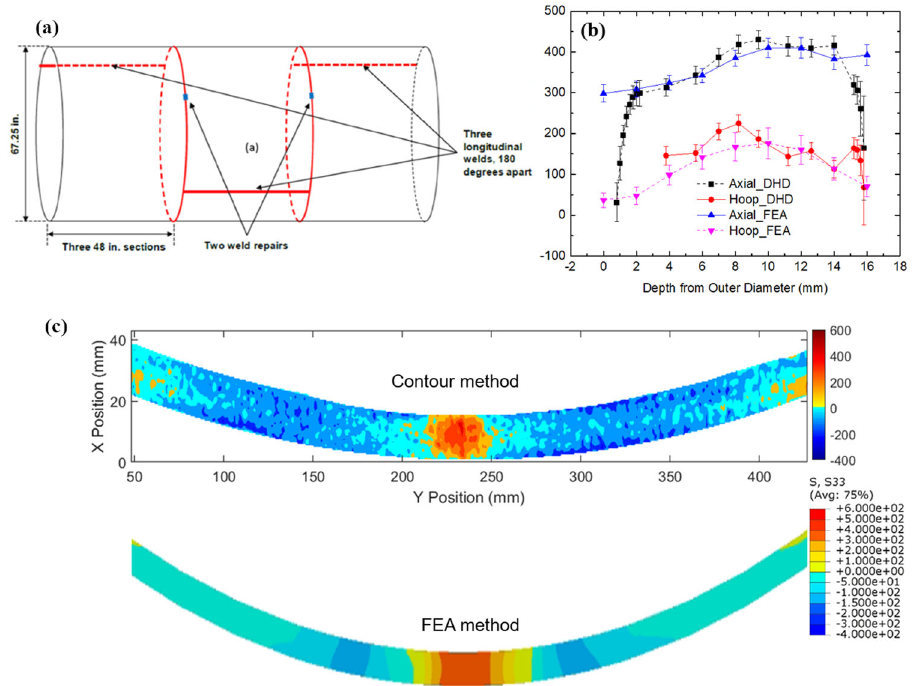
Fig. 1 Residual stresses simulation results and the comparison with experimental data. a Schematic drawing of the mockup and b residual stress pro fi les in weld centerline of longitudinal Type 304 stainless steel weld from FEA (dashed lines) and DHD (deep-hole drilling) measurements (solid lines), c cross-section axial stress contour distributions for longitudinal Type 304 stainless steel weld from contour method and FEA. The DHD data and contour measurement data is from ref. 12 . The error bars in b represent standard deviation of the data along the axial direction of the